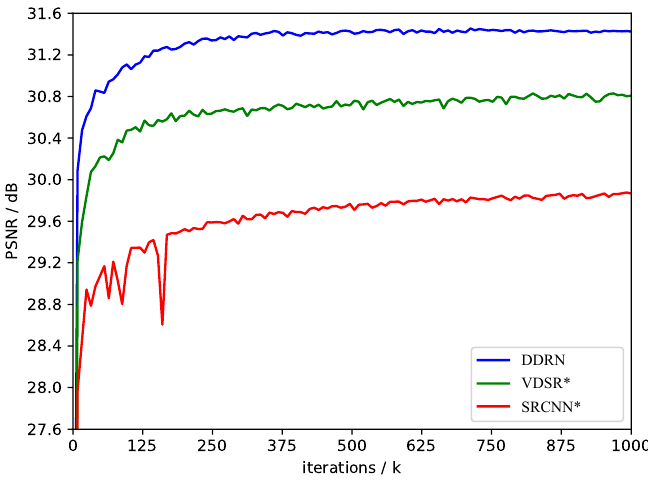
Figure 5. Training process for different models with the scale of 4. On the top, the blue line denotes the convergence process of the basic module DDRN with depth of 15 while the green and the red lines at the bottom refer to the VDSR and SRCNN. The competitive algorithms marked by * denote the retrained versions with our